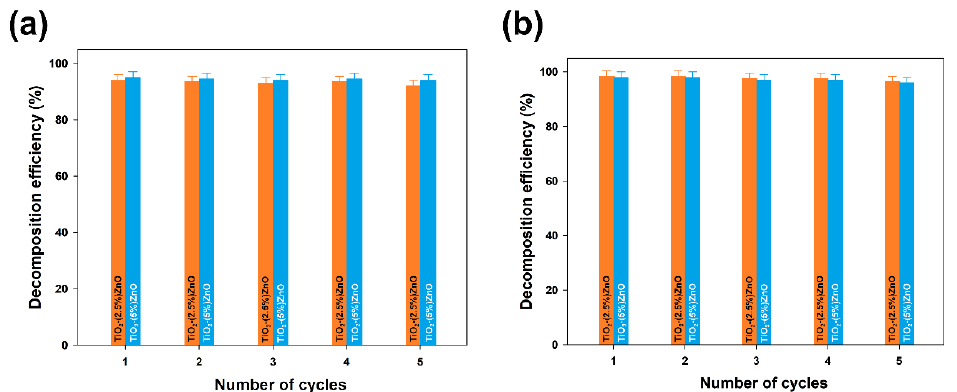
Figure 13. The efficiency of 4-chlorophenol decomposition in the presence of TiO 2 -(2.5%)ZnO and TiO 2 -(5%)ZnO samples during five successive cycles using 10W ( a ) and 20W ( b ) UV-LED light